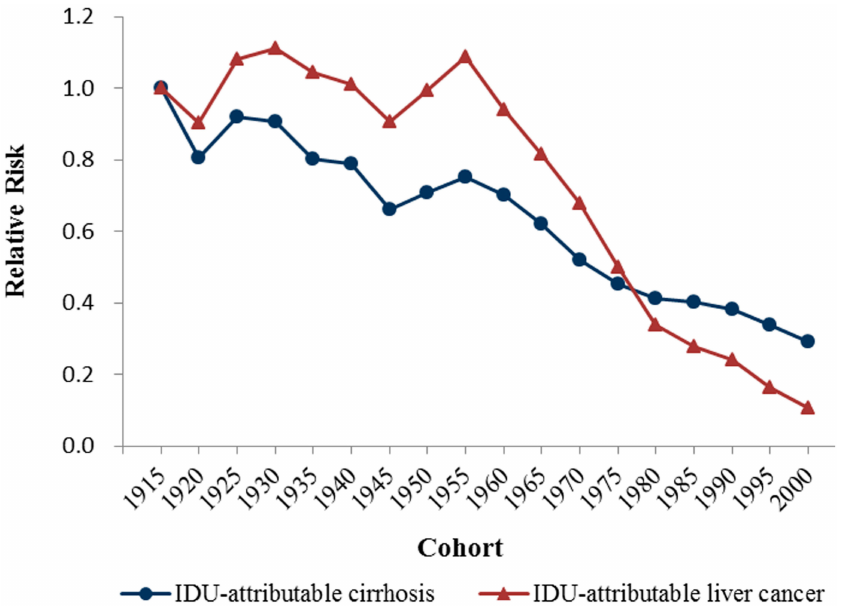
Figure 5. Cohort effects on mortality rates of IDU-attributable cirrhosis and IDU-attributable liver